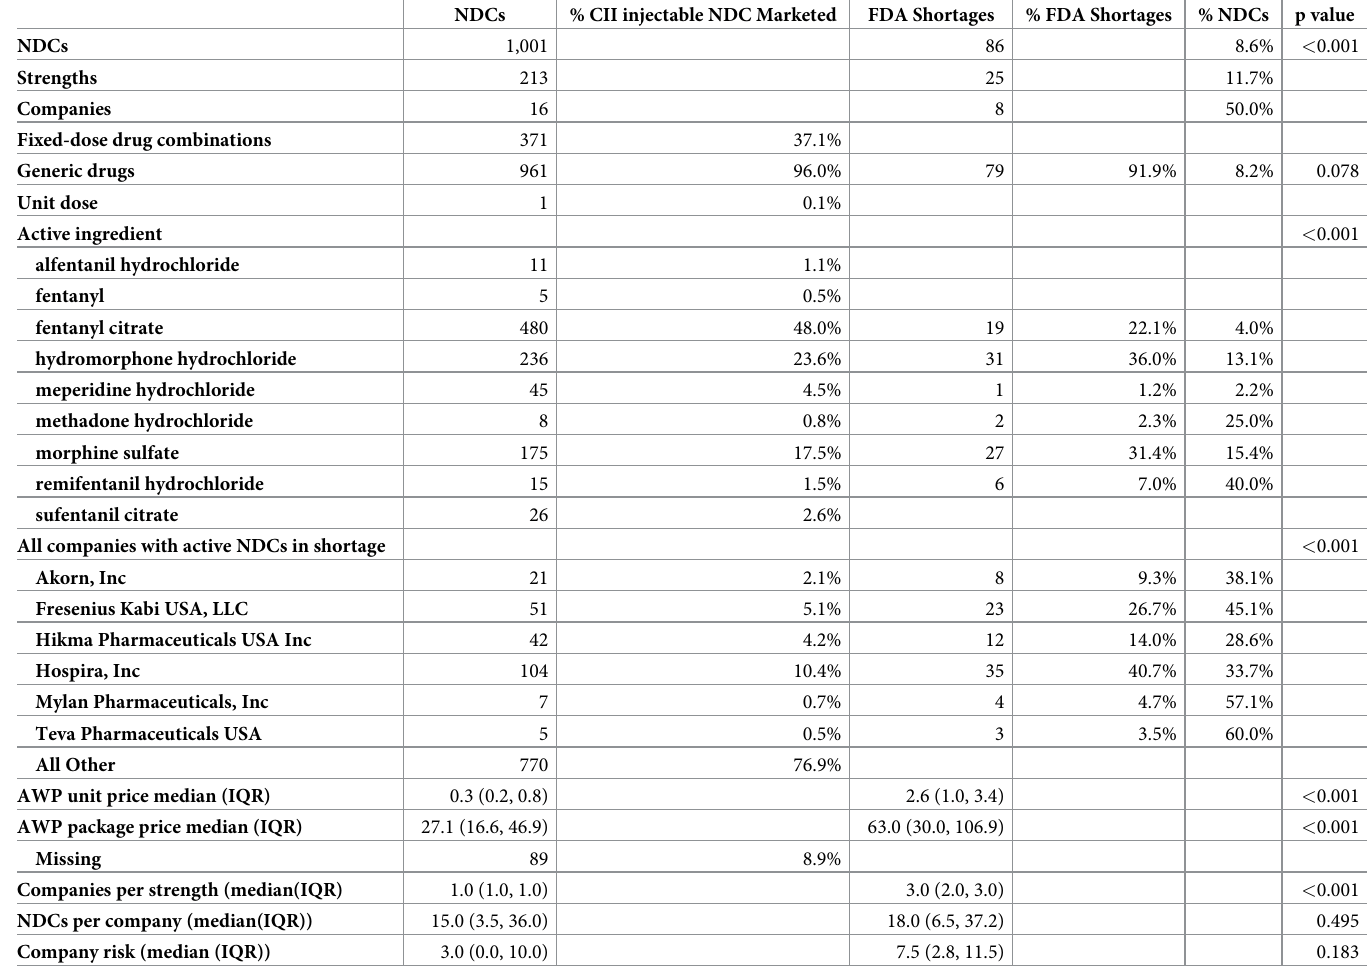
Table 3. DEA schedule CII injectable opioid NDCs marketed and shortages,